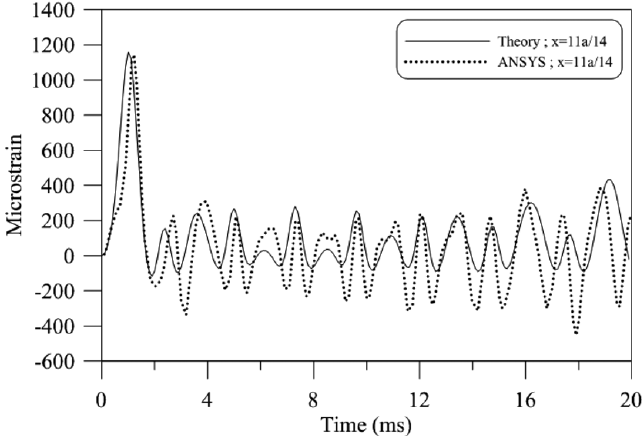
Fig. 15. The strain-time history ( ε xt − t ) at top surface of point (7a/14, b/2).